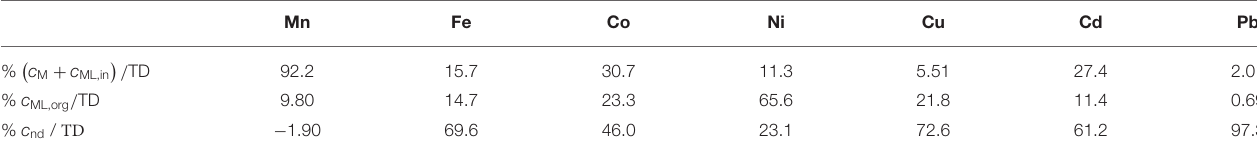
c M + c ML,in TABLE 4 | Percentage distribution of lumped inorganic species, organic Complexes, c ML,org , and Non-dynamic Species, c nd in the Wyre river (Warnken (cid:0) (cid:1) et al., 2008) when taking D ML,org as twice of those for isolated fulvic acid complexes. Mn Fe Co Ni Cu Cd c M + c ML,in / % (cid:1) (cid:0)